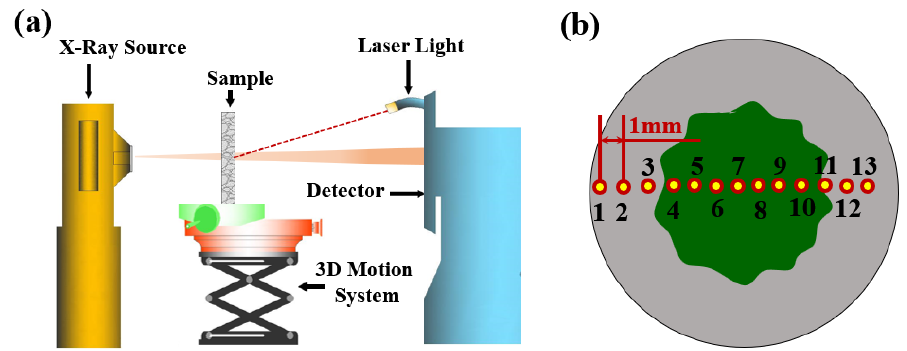
Figure 2. XRAM apparatus and sampling position. ( a ) Schematic of XRAM apparatus; ( b ) sampling location.